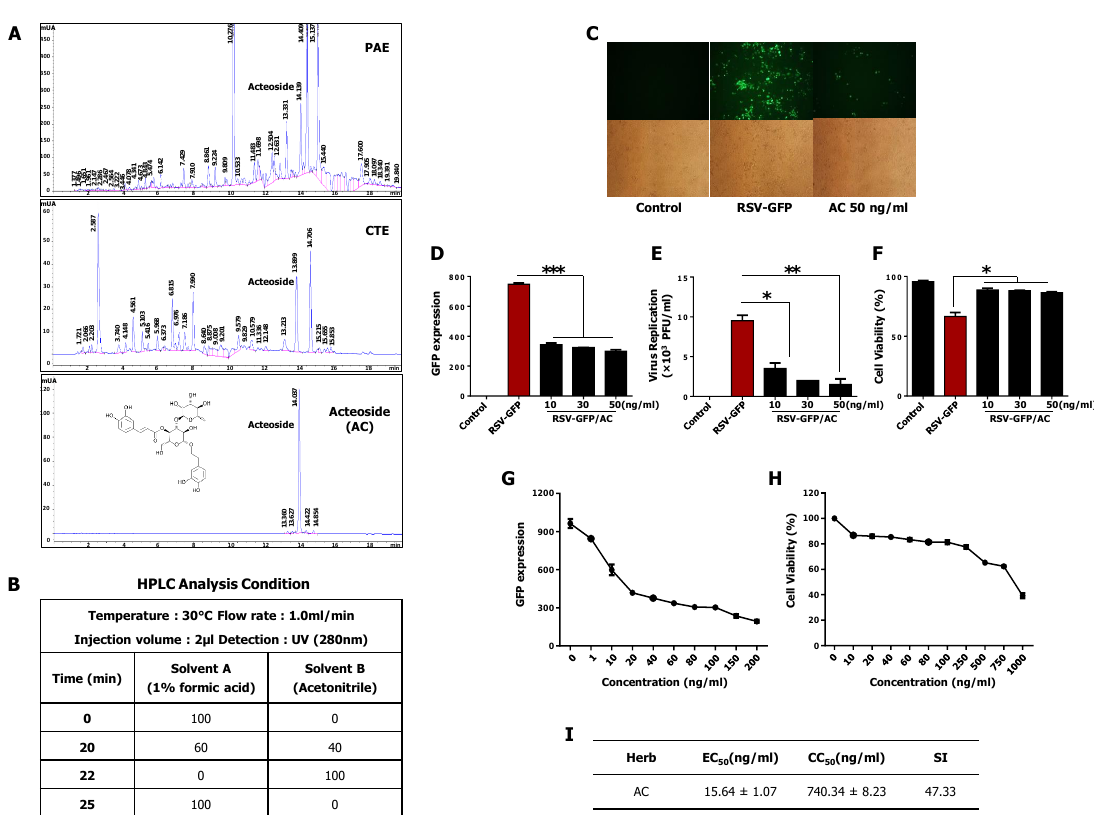
Figure 5. Identification and antiviral e ff ect of acteoside (AC) in-vitro. ( A , B ) Chemical compounds in PAE and CTE were analyzed by the reversed phase HPLC. The monolayer of HEp2 cells was infected with RSV-GFP (0.1MOI) for 2 h with DMEM containing 1% FBS. Then, the medium was replaced with DMEM containing 10% FBS and cells were treated with 10, 30, 50 (ng / mL) AC. ( C ) After 48 h, images were obtained (200 × magnification). ( D ) GFP absorbance levels were measured by Gloma multi-detection luminometer (Promega). ( E ) Viruses were titrated from the cell supernatant and cells by standard plaque assay. ( F ) Cell viability was determined by trypan blue exclusion assay at 48 hpi. ( A ) HEp2 cells were infected with RSV-GFP (O.1MOI) for 2 h with DMEM containing 1% FBS. Then, the medium was changed to DMEM containing 10% FBS and cells were treated with various concentrations AC. 48 hpi GFP expression level was determined. ( G ) HEp2 cells were treated with various concentrations of AC and cell viability was determined at 48 hpi by cell cytotoxicity assay kit. ( H ) To calculate EC 50 value, 50% reduction of GFP expression was considered as equivalent to the 50% reduction in virus titer. ( I ) The ratio between CC 50 and EC 50 considered as Selectivity Index (SI). GFP absorbance, cell viability and virus titer expressed as mean ± SD. Error bars indicate the range of values obtained from counting duplicate in three independent experiments. In vivo experiment was performed in duplicate. (* p < 0.05, ** p < 0.01 and *** p < 0.001 regarded as significant di ff